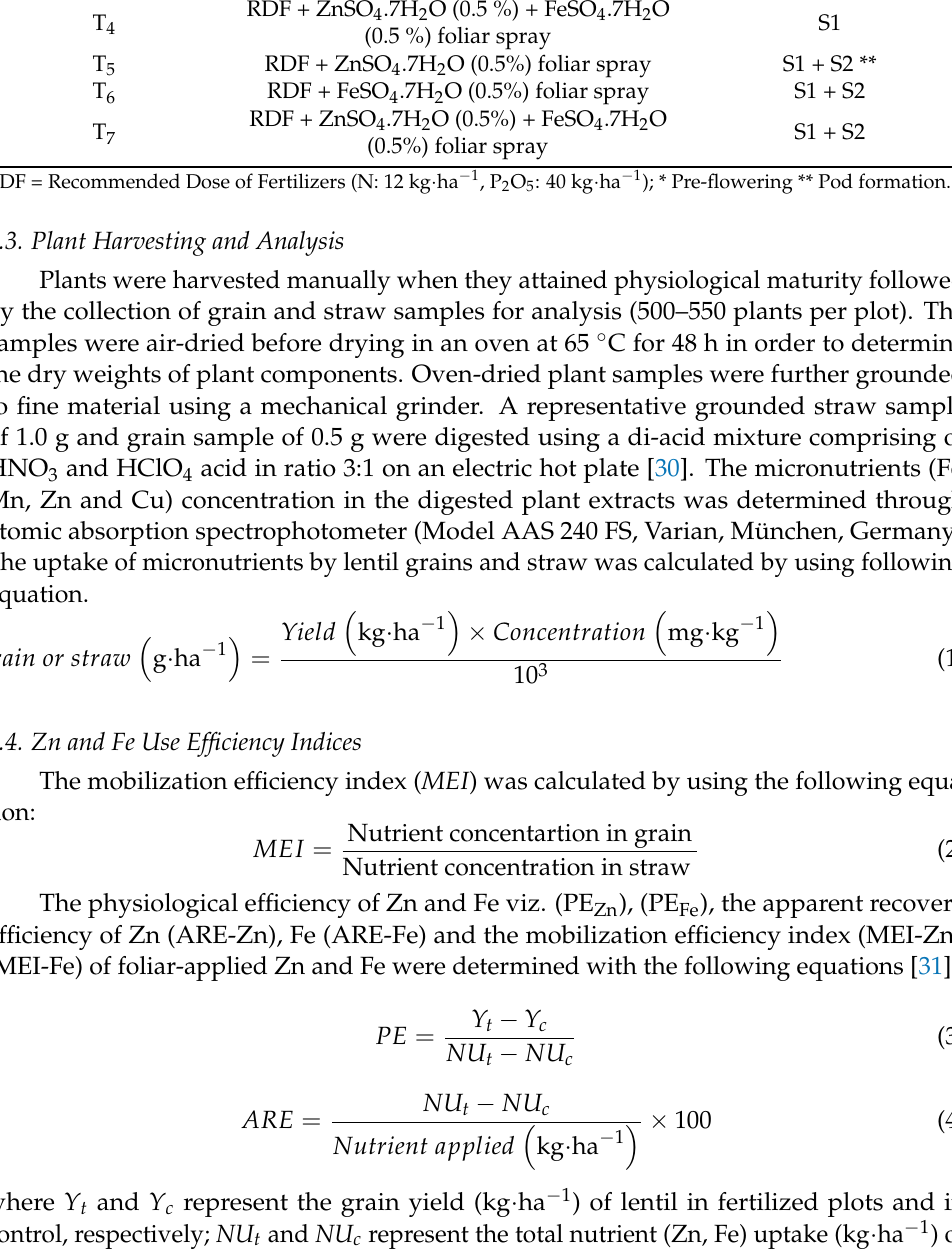
Table 1. Treatment details of the experimental field at the time of sowing of lentil. SL. No Treatments Stage of Application T 1 RDF (control) T 2 RDF + ZnSO 4 .7H 2 O (0.5%) foliar